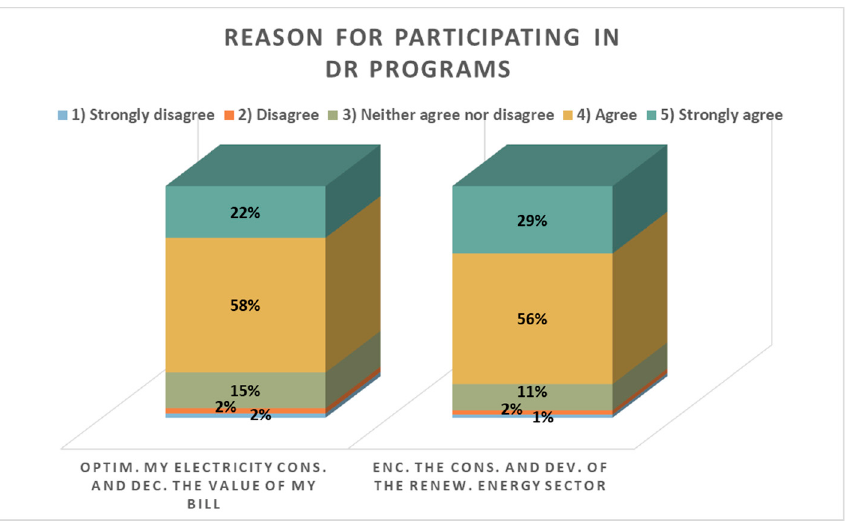
Figure 7. Participation of consumers in DR programs in order to optimise electricity consumption and decrease electricity bills, or to develop the renewable energy sector.